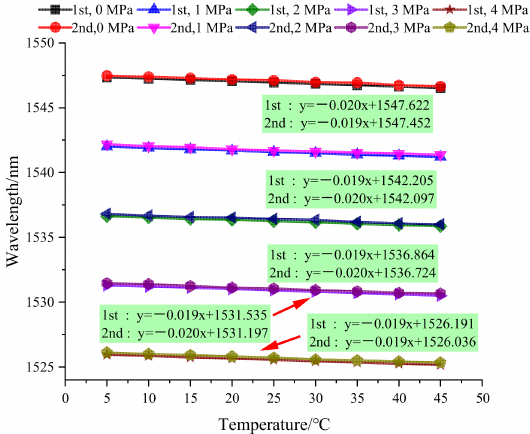
Figure 11. Sensor creep